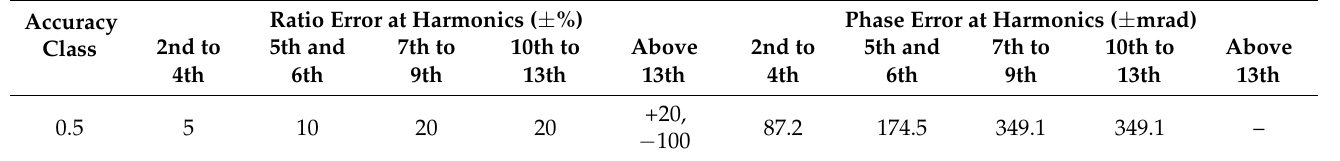
Table 7. Accuracy limits from